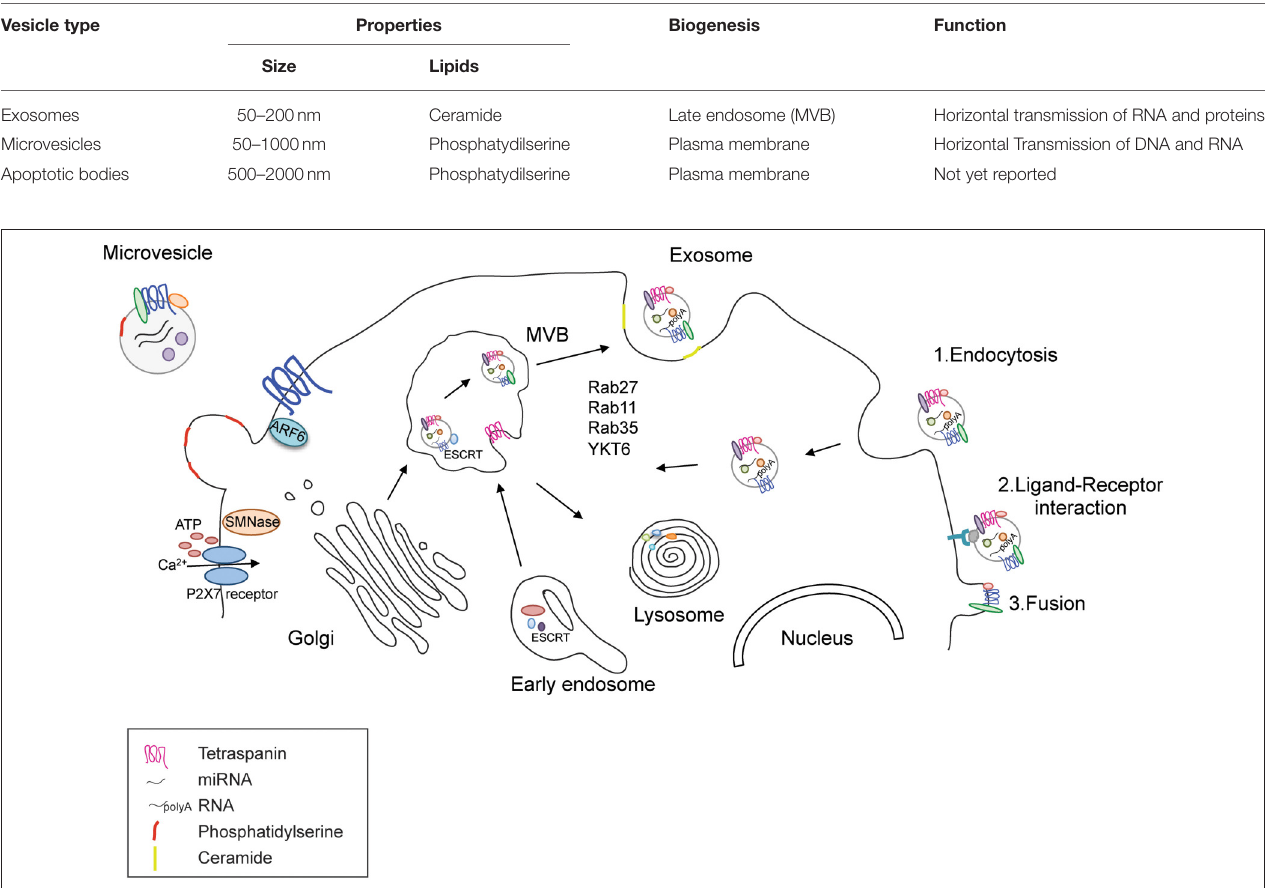
FIGURE 1 | Release and uptake of MVs and exosomes. Functional EVs are released through two different pathways; MVs bud directly from the plasma membrane upon increase of extracellular ATP that opens the P2X7 receptor and allows the entrance of calcium. Their membrane is enriched in phosphatydil serine and tetraspanins. Their cargo contains and cytoplasmic proteins, RNAs and DNAs. Exosomes are derived from the late endosome or multivesicular bodies (MVB) where ESCRT coordinates the cargo loading and vesicle release. Rab GTPases, such as Rab27, 35, 11 and the SNARE protein YKY6 coordinate vesicle tethering and fusion to the plasma membrane. The cargo content comprises proteins and RNAs like in MVs. The presence of DNA is highly debated. Exosomes can enter in recipient cells trough endocytosis, ligand-receptor interaction (where both the ligand and the receptor are not clearly uncovered) or fusion with the plasma